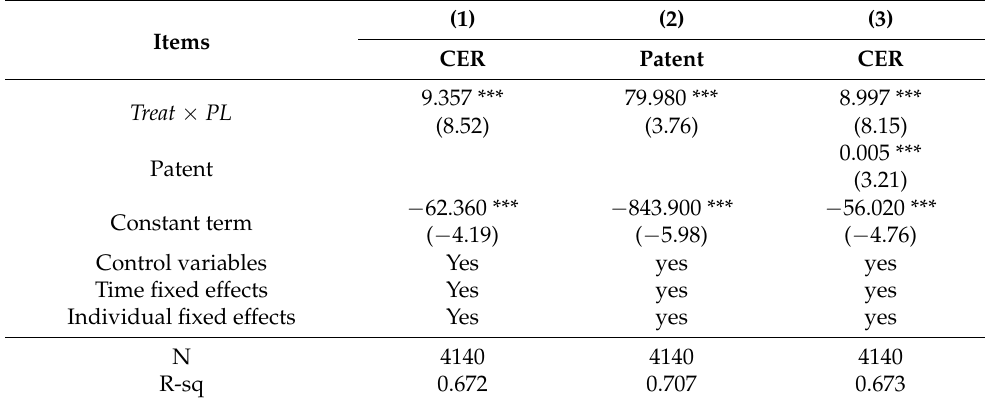
Table 6. Results of mediating effect of the number of patents